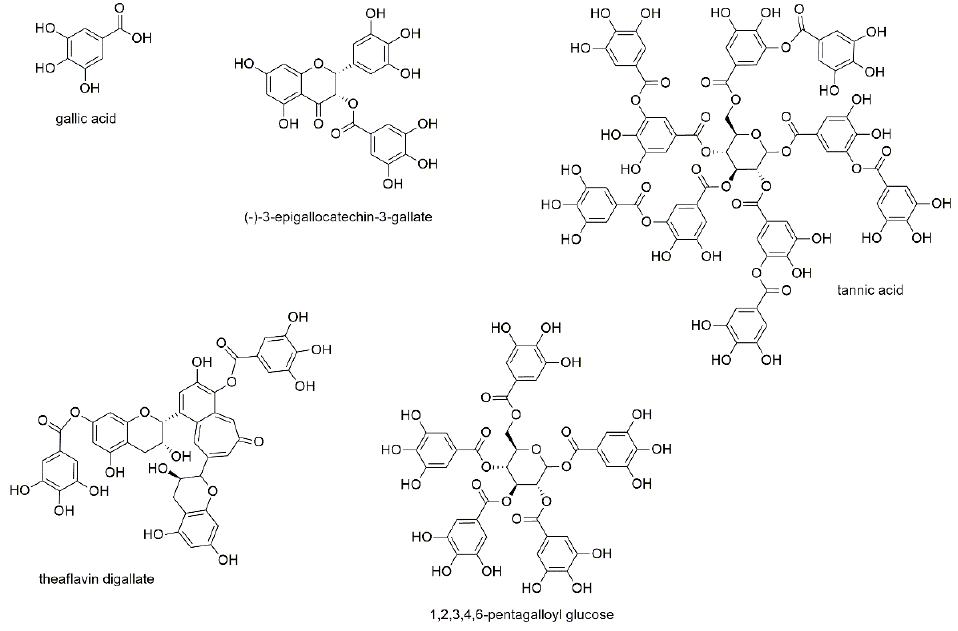
Figure 10. Gallic acid derivatives with reported activity against myeloma cell lines.